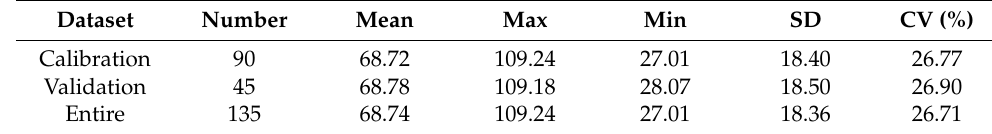
Table 2. Descriptive statistics of SS (g kg − 1 ).